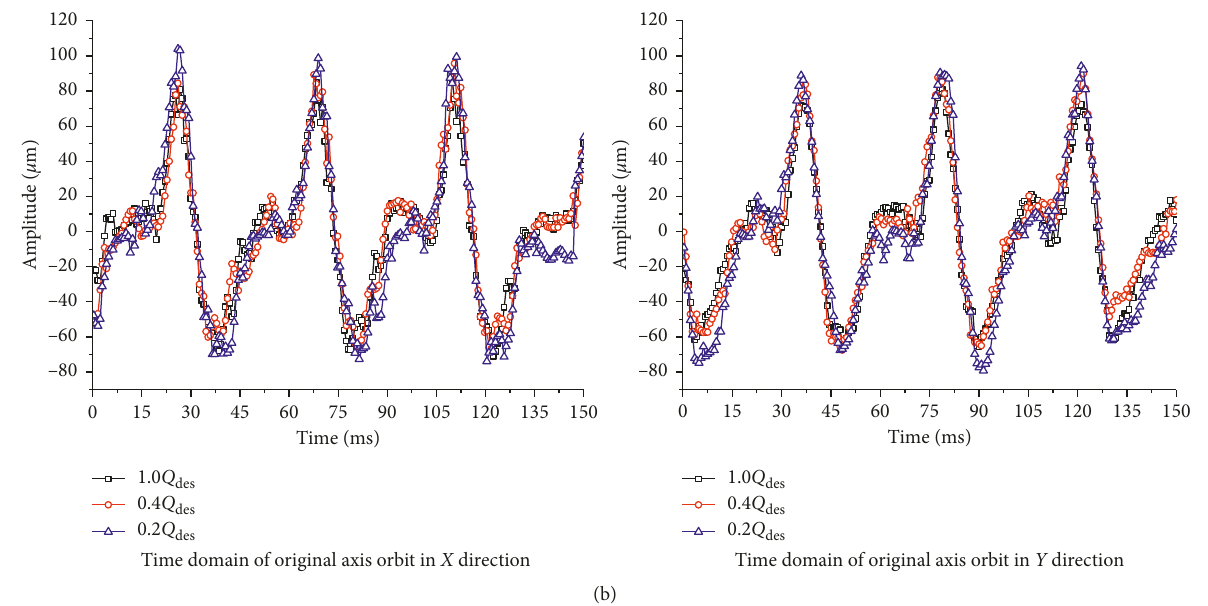
Figure 9: Axis orbit and time-domain diagram of the original. (a) Original axis orbit diagram. (b) Time-domain diagram of axis